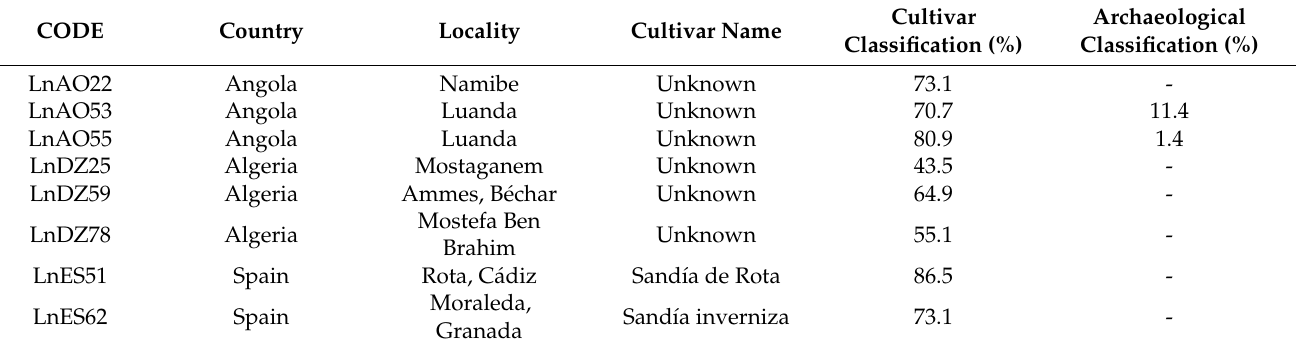
Table 3. Correct classification percentage between Citrullus lanatus var. lanatus cultivars and Middle Ages seeds considered as